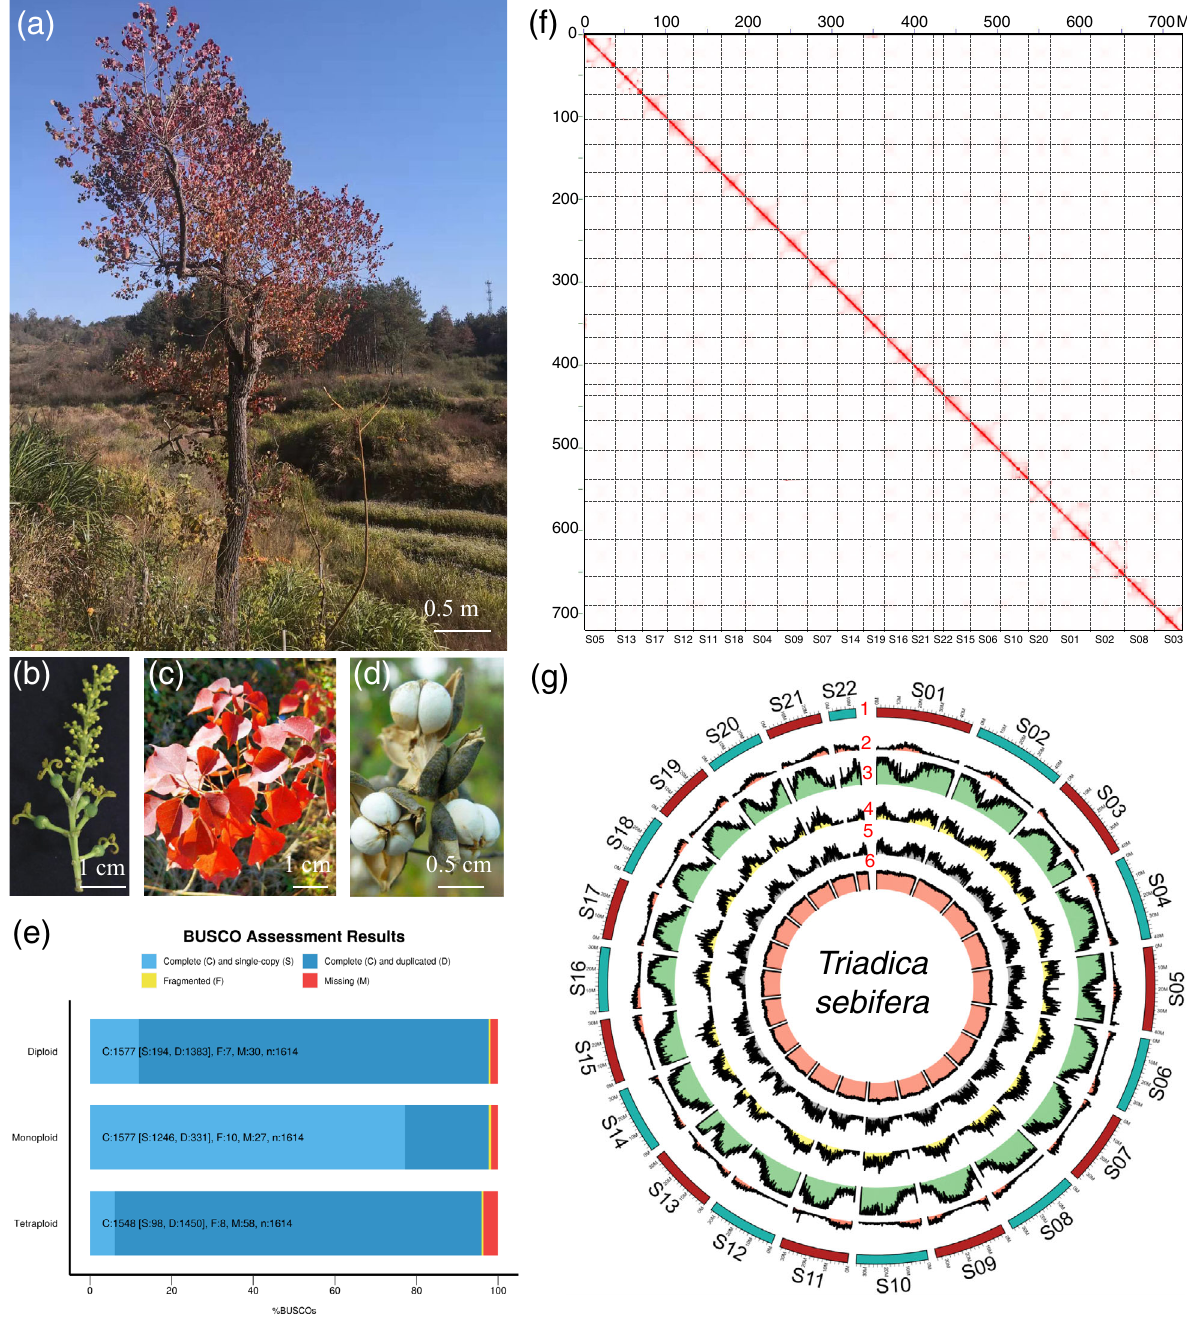
Fig. 1 Genome assembly of the Chinese tallow tree (CTT). a The line used as plant material in this study grows in Luotian County, Hubei Province, China. b – d show magni fi ed images of fl uorescence, red leaves, and seeds, respectively. e BUSCO assessment of the monoploid, diploid and tetraploid assemblies. f Plot of the Hi-C matrix for the chromosome-scale monoploid genome of the CTT. The chromosome orders for the x and y axis are the same and they are labeled in the bottom of this fi gure. g Genome features of the chromosome-scale monoploid genome of the CTT. Numbers 1 to 6 represent scaffolds (pseudochromosomes), gene density, repeat content, Gypsy transposon content, Copia transposon content, and GC content, respectively. Photos in this fi gure are originals and they were taken by the corresponding author Dr. Nian